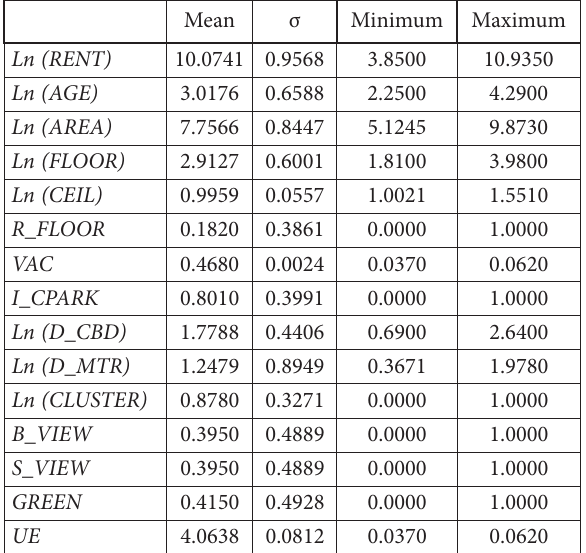
Table 5. Descriptive statistics of the office property data